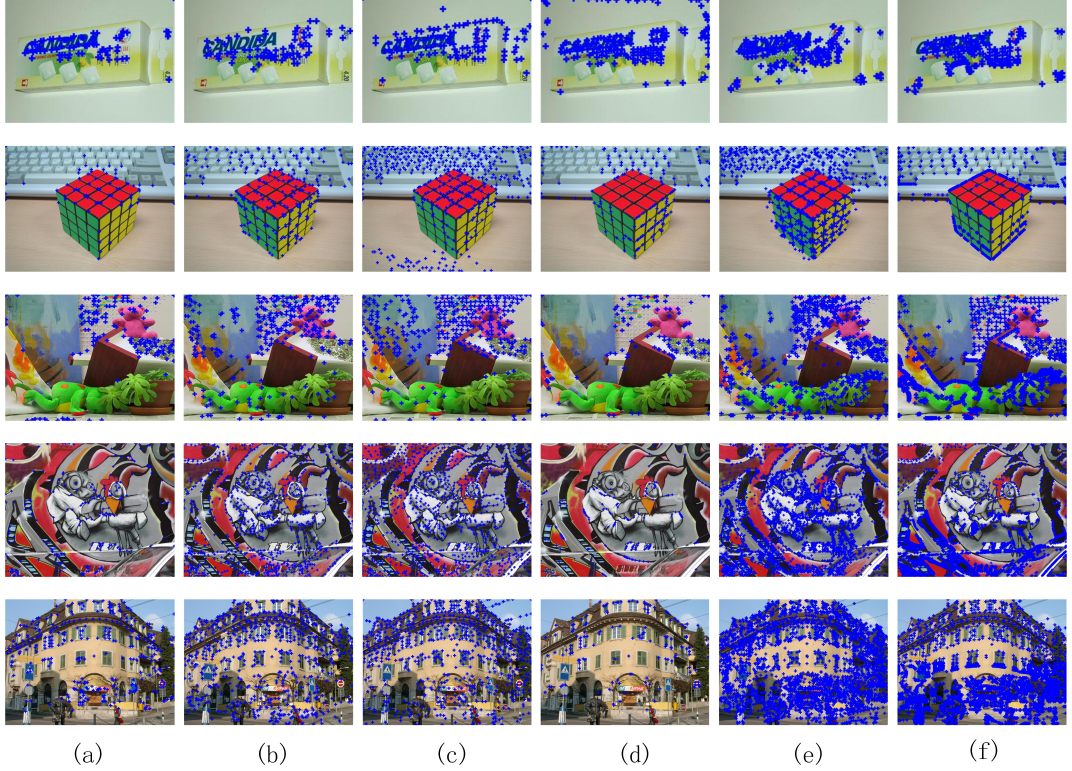
Figure 9. Feature points extraction under different algorithms: ( a ) corner detector (CD) ( b ) Gilles ( c ) Harris ( d ) LoG ( e ) SIFT ( f )